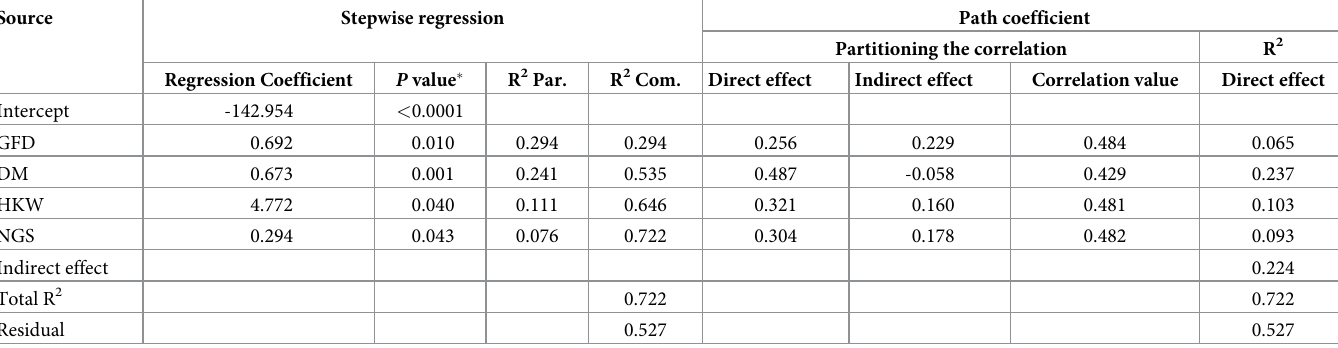
Table 7. Stepwise regression and path coefficient analyses for grain yield (dependent variable) with four yield-related traits (independent variables) for combined data across seasons.